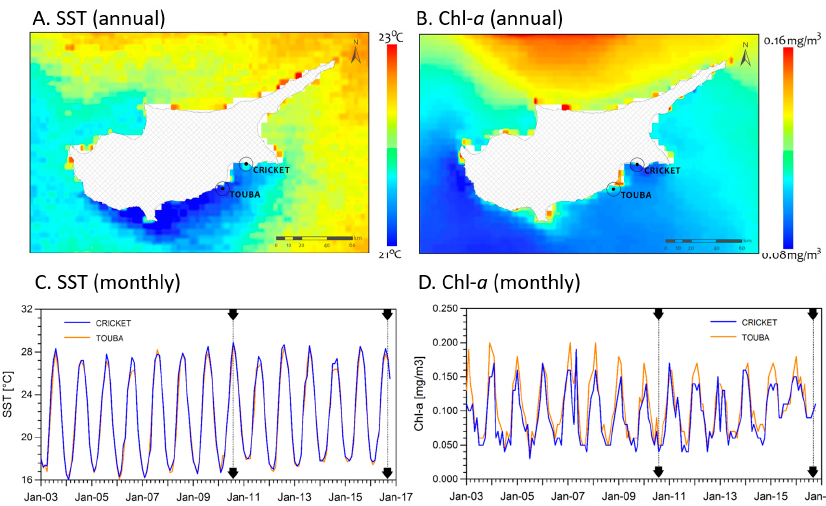
Figure 1. Satellite ‐ derived sea surface temperature (SST) and chlorophyll ‐ a (Chl ‐ a ). ( A , B ) Annual mean (2003–2016) around Cyprus; ( C , D ) Monthly mean (2003–2016) at the study sites Touba and Cricket. Date format MMM ‐ YY. Black arrows indicate the months when the shipwrecks were studied.